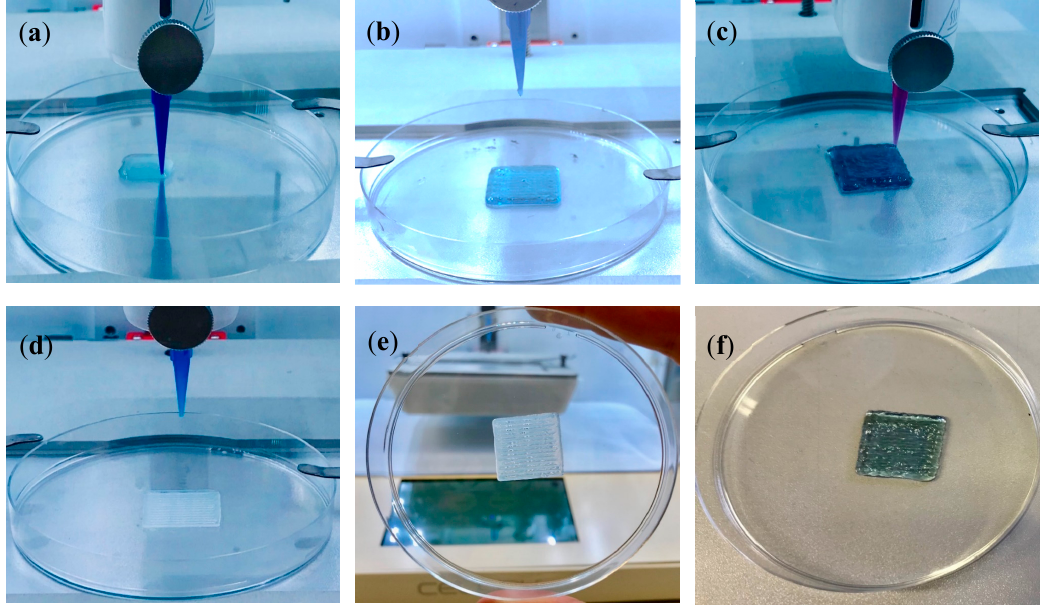
Figure 4. ( a ) CH–GE–PEG 3D printed constructs having 0.5% w/v GE, ( b ) CH–GE–PEG 3D printed constructs having 1% w/v GE, ( c ) CH–GE–PEG 3D printed Figure constructs having 2% w/v GE, ( d ) bioprinting of alginate as first layer, ( e ) bioprinted alginate layer from another view, ( f ) bioprinted alginate/CH–GE–PEG/KCs– HDFs 3D constructs with 1% GE.